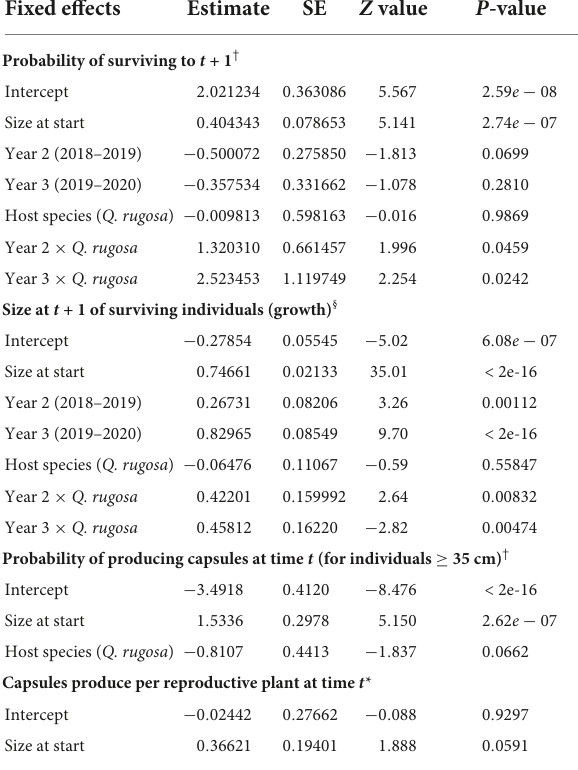
TABLE 4 Estimated coefficients from mixed-effect models of the probability of survival, growth, reproduction, and probability of producing capsules for Oncidium brachyandrum plants growing on two Quercus